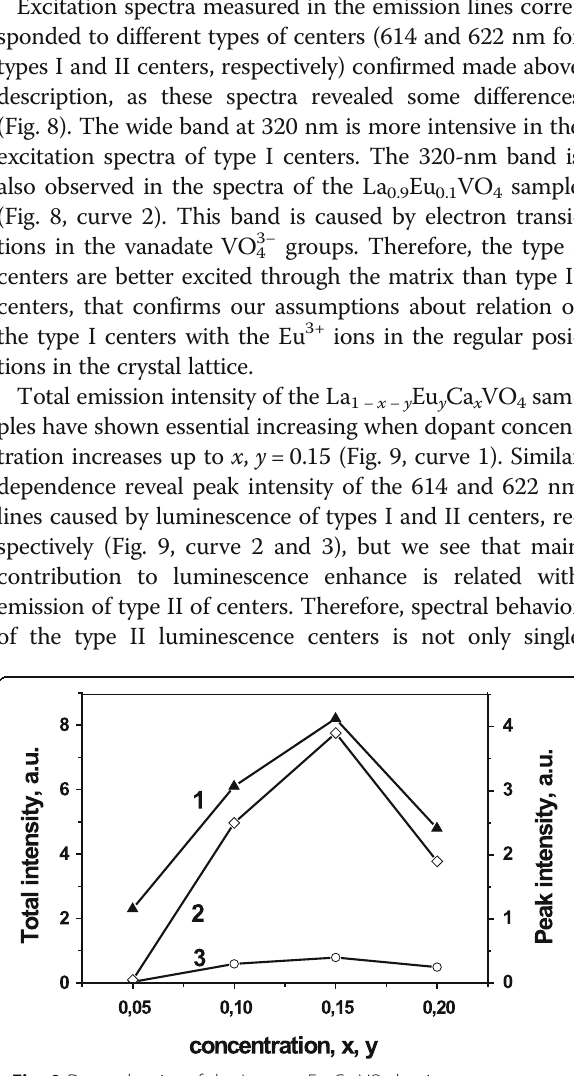
Fig. 9 Dependencies of the La 1 − x − y Eu y Ca x VO 4 luminescence intensity on dopant concentration x ; total emission ( 1 ) and 622 nm peak intensity ( 2 , 3 ); λ ex = 405 ( 1 , 2 ) and 473 nm ( 3